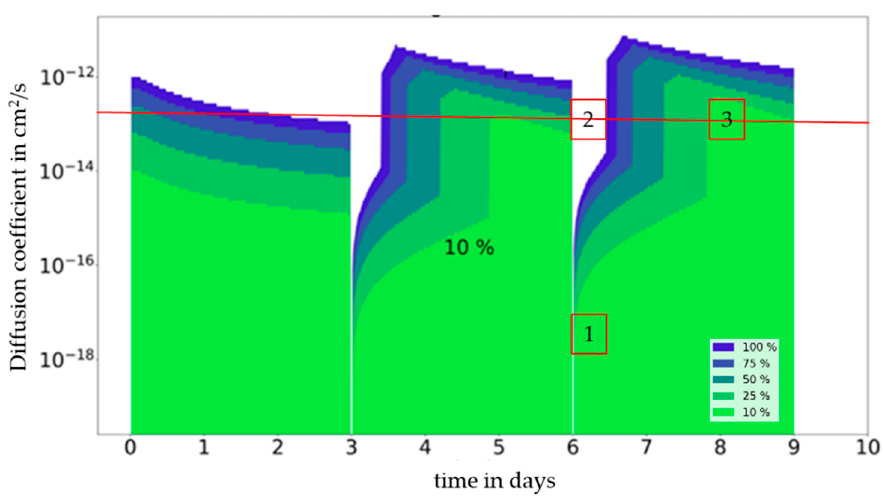
Figure 5. Repeated-use: Map of time (t) in minutes against diffusion coefficient (D P ) in cm 2 /s. Deviation of migration in mg in dependence from partition coefficient (K P,F ) expressed in % at a given initial concentration (1000 mg/kg), material thickness (2000 µm), and area to volume ratio (6 dm 2 per kg food). For a description of positions 1 to 3 see text.